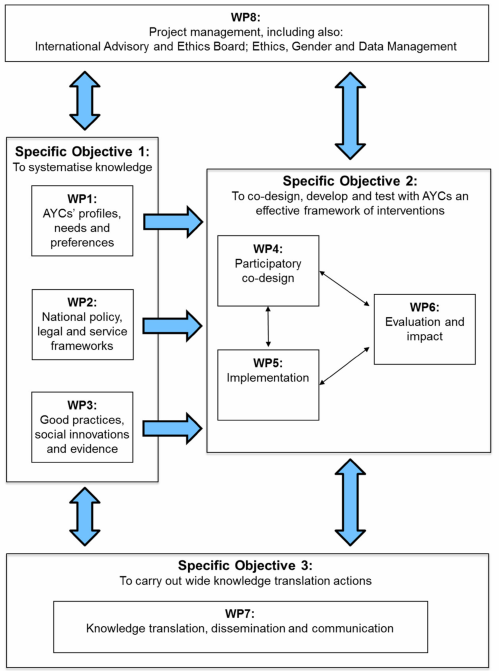
Figure 1. PERT chart of WPs and objectives in the ME-WE